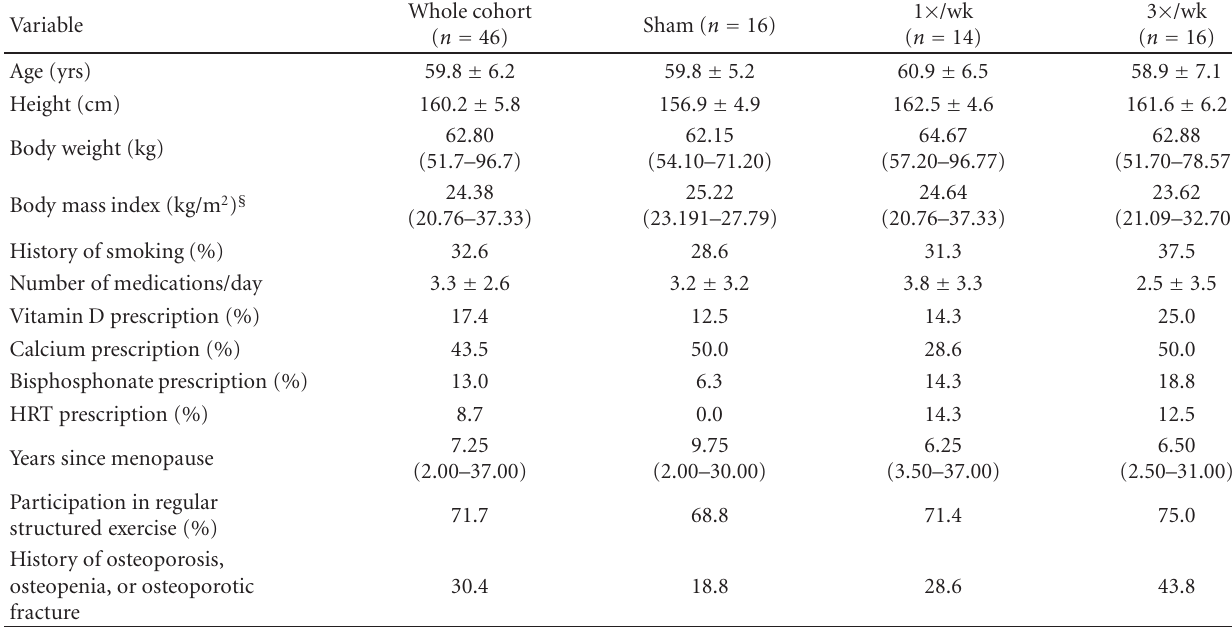
Table 1: Demographics and health status.